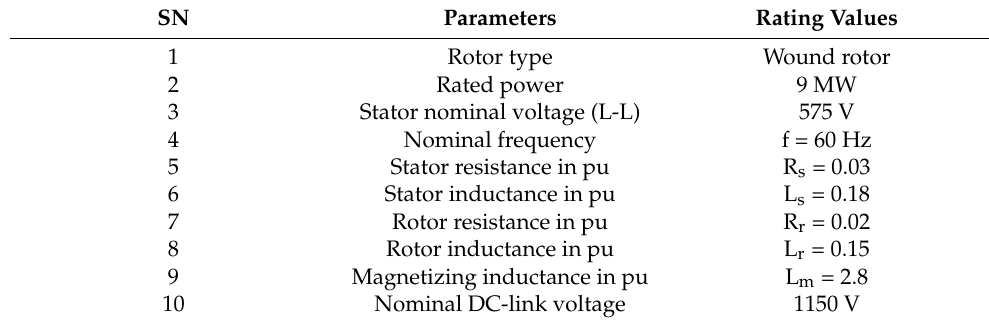
Table 3. Design specifications for